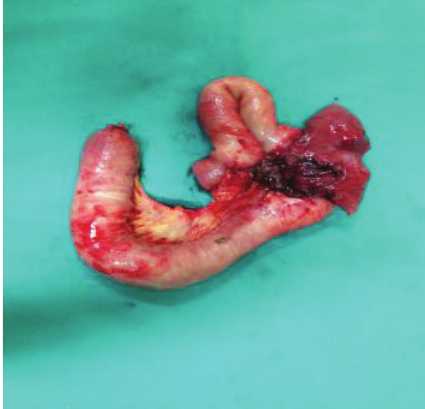
Figure 3: Image of the small bowel resection en bloc with part of affected sigmoid colon.